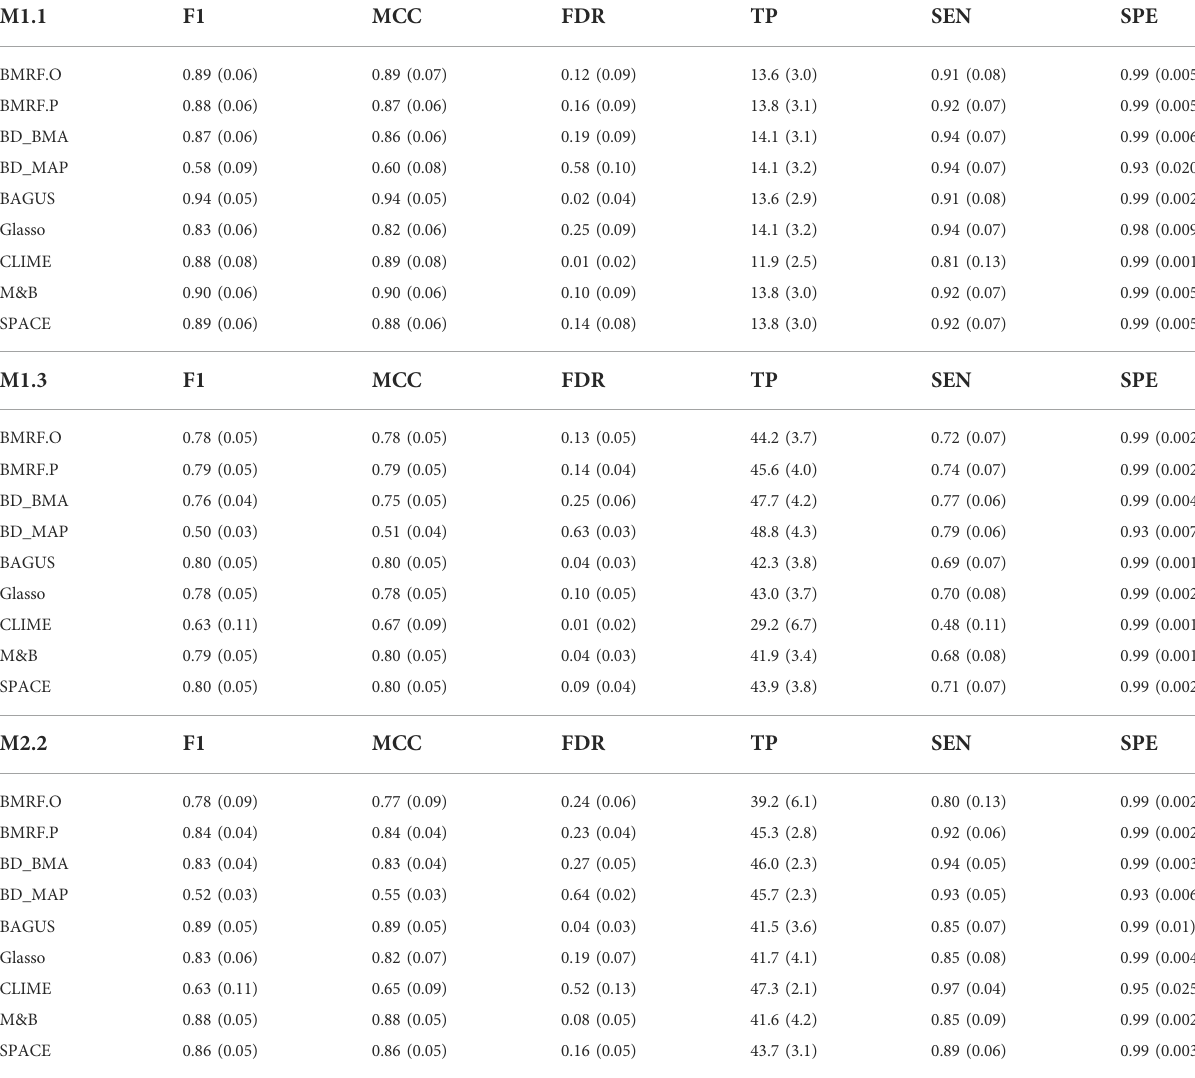
TABLE 1Values of six evaluation criteria (F1, MCC,FDR, TP, SEN, andSPE) under simulation settings M1.1,M1.3,andM2.2.Each valueis the average of 100 replications with standard error (SE) in parentheses.